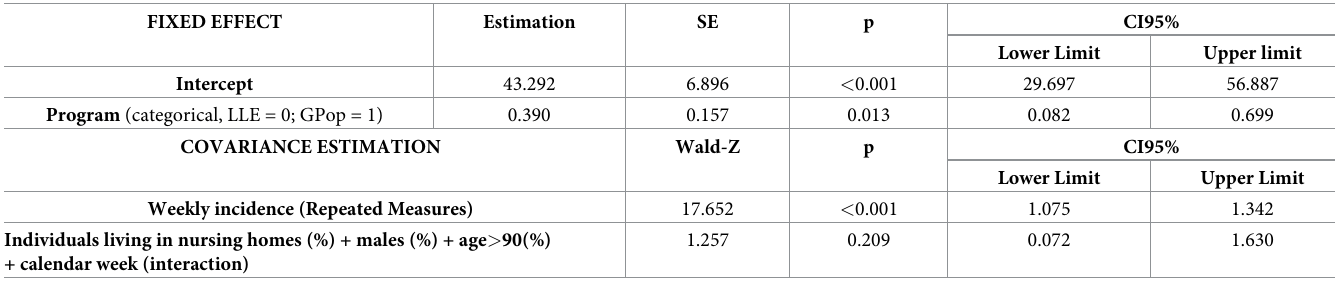
Table 3. Mixed linear model–fixed effect and covariances estimation �